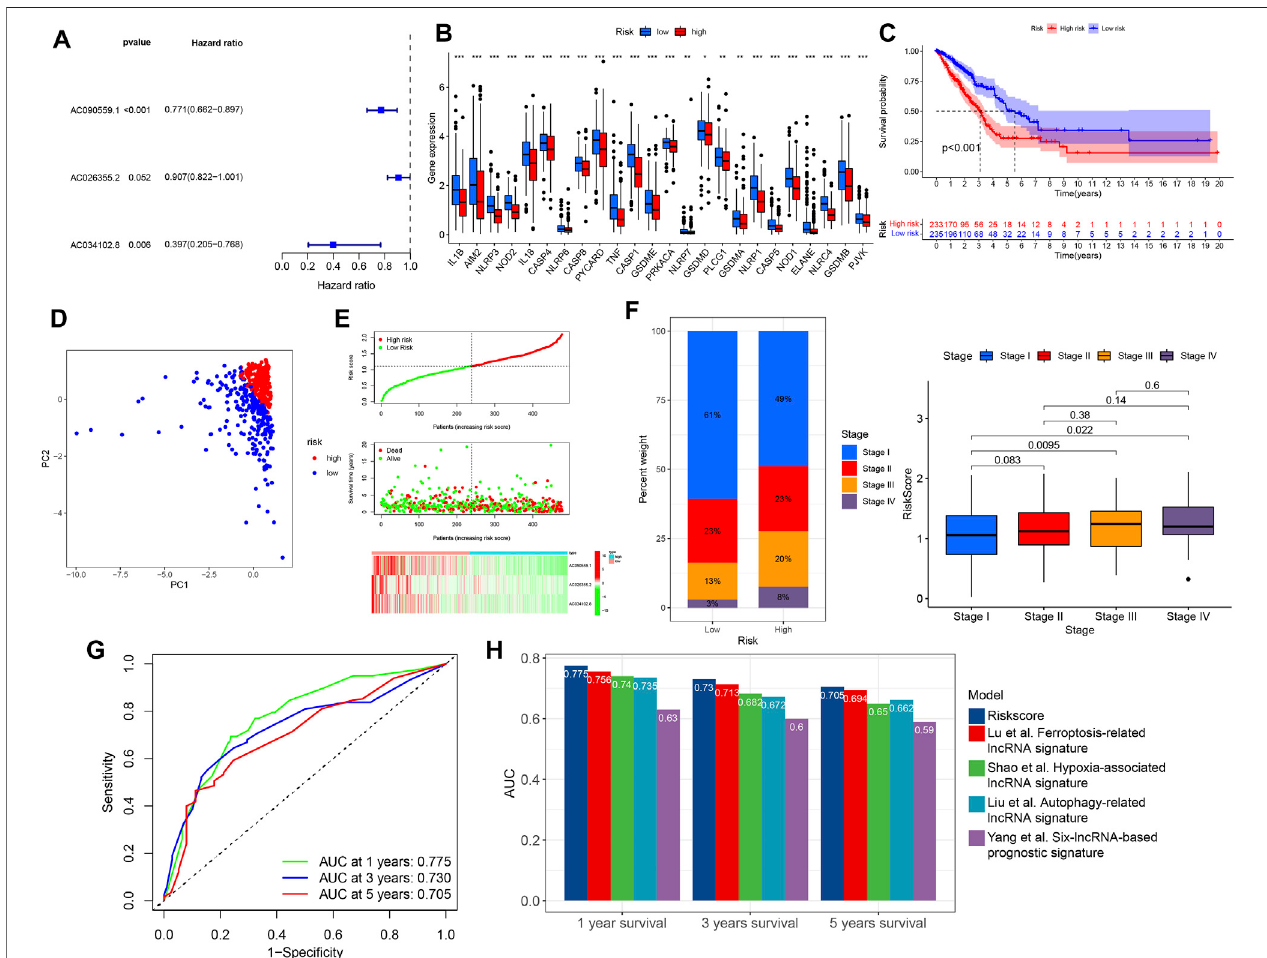
FIGURE 3 | Construction of risk model and clinical correlation of high- and low-risk groups. (A) Three lncRNAs were identi fi ed in multivariate Cox regression analysis for model construction. (B) Differential expression of pyroptosis-related genes between high- and low-risk groups (Wilcoxon test, * p < 0.05; ** p < 0.01; *** p < 0.001). (C) Kaplan – Meier curve of high- and low-risk groups. (D) PCA of high and low-risk groups. (E) Risk curve based on the risk score of each sample. Scatterplot showingthesurvivalstatusofLUADpatients.Heatmapshowingtheexpressionofidenti fi edlncRNAsinhigh-andlow-riskgroups. (F) Relationshipbetweentumor stage and risk score. (G) Time-dependent ROC curves of OS at 1, 3, and 5 years. (H) Comparison of the risk model with four published lncRNA signatures. OS, overall survival; PCA, principal component analysis.